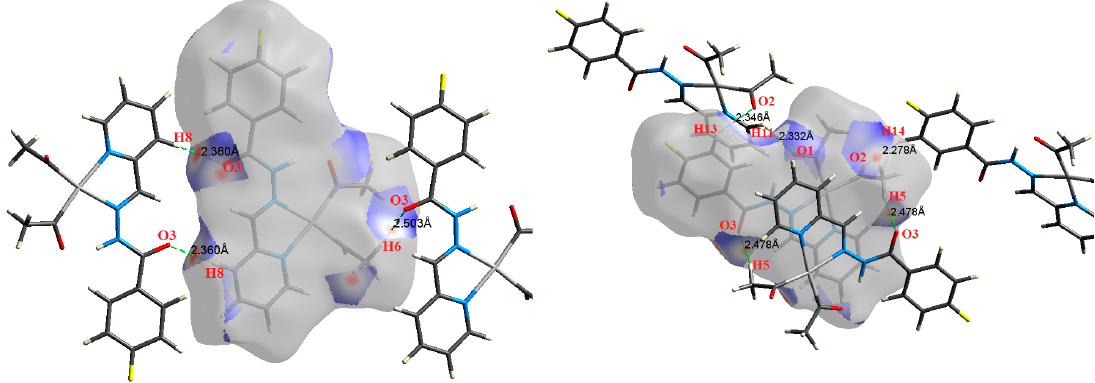
Figure 8. The most important intermolecular contacts in complex 6 .